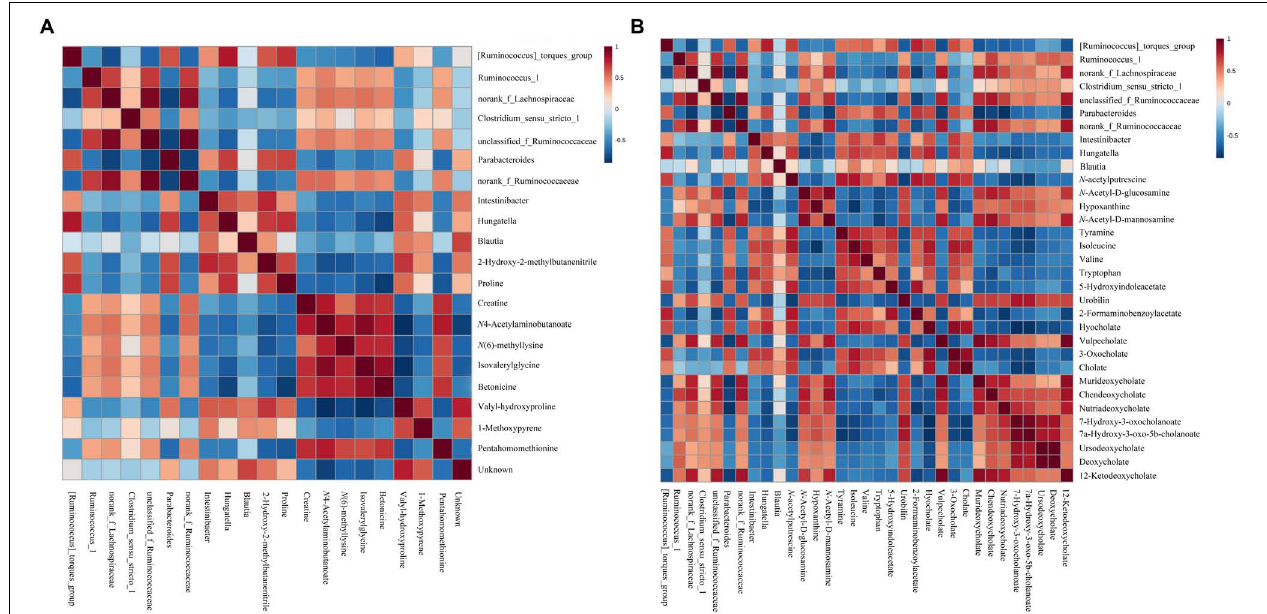
FIGURE 5 | Correlation heat map showing the significant statistical correlation values ( r ) between perturbed gut microbiota genera and altered urinary (A) and fecal (B) metabolites in rats with antibiotic-induced gut microbiota dysbiosis. Red squares represent significant positive correlations ( r > 0.5, p < 0.05), blue squares represent significant negative correlations ( r < –0.5, p < 0.05), and white squares represent non-significant